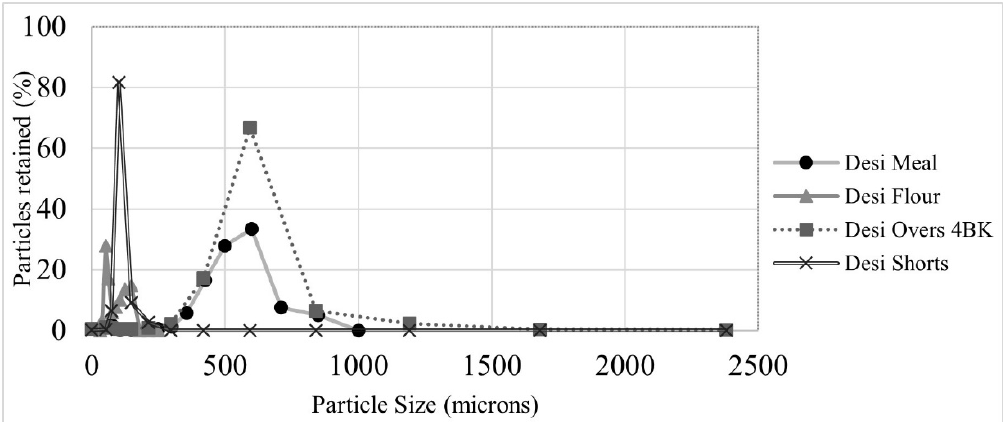
Figure 4. Particle Size of Process 2, (Desi) Milling Streams .